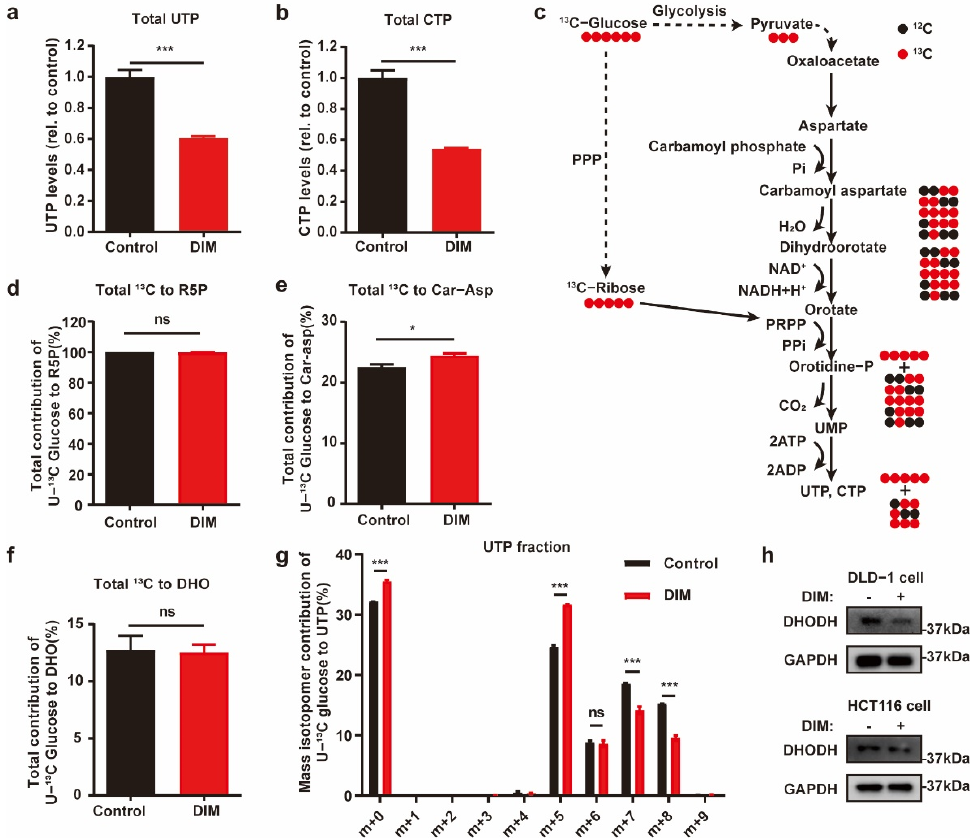
Figure 3. Metabolic profiling reveals de novo pyrimidine biosynthesis alteration in CRC under DIM treatment. ( a ) Total content of UTP in control and 40 μ M DIM-treated HCT116 cells. ( b ) Intracellular CTP levels in control and 40 μ M DIM-treated HCT116 cells. ( c ) Schematic overview of 13 C-glucose- traced pyrimidine biosynthesis. Black circle: 12 C; red circle: 13 C. ( d ) Total labeled carbons in ribose- 5-phosphate (R5P) of control and DIM-treated HCT116 cells following a 13 C-glucose treatment. ( e ) Total labeled carbons in Car-Asp of control and DIM-treated HCT116 cells following a 13 C-glucose treatment. ( f ) Total labeled carbons in DHO of control and DIM-treated HCT116 cells following a 13 C-glucose treatment. ( g ) Fraction enrichment of 13 C-glucose derived isotopologues in UTP in con- trol and 40 μ M DIM-treated HCT116 cells. ( h ) Western blot analysis after DIM treatment using anti- DHODH. GAPDH was used as the internal control in DLD-1 and HCT116 cells. Data are presented as mean ± SEM. ns, no significance; *, p < 0.05; ***, p < 0.001; unpaired two-tailed Student t -test.